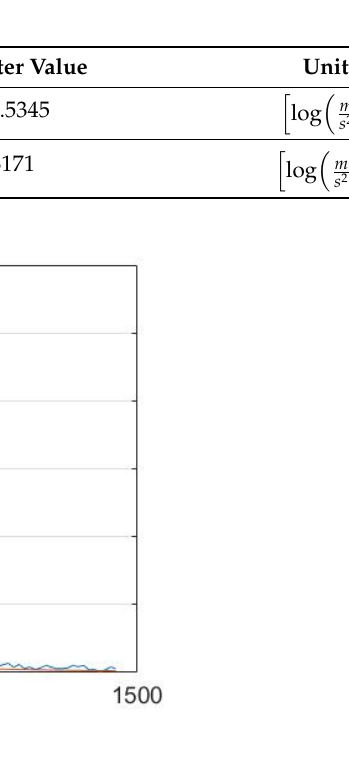
Figure 16. Example of noise-free signal and noise-added signal. Table 2. Lognormal distribution parameters.